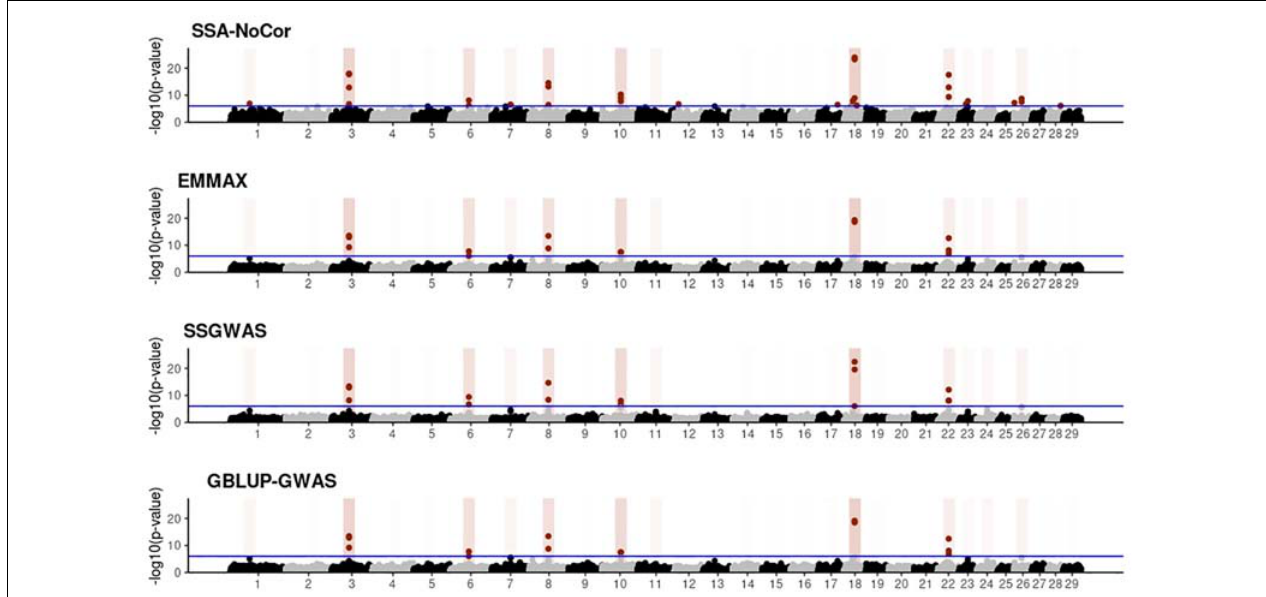
FIGURE 9 | Manhattan plots for the large population of beef cattle using single-SNP analysis without correction for population structure (SSA-NoCor), efficient mixed-model association expedited (EMMAX), single-step GWAS (ssGWAS), and genomic best linear unbiased prediction GWAS (GBLUP-GWAS). Significant SNPs are indicated in red, whereas vertical bars indicate the position of the simulated quantitative trait nucleotide (QTN). The darker the vertical bar, the stronger QTN effect. The blue horizontal line corresponds to the rejection threshold based on a significance level of 0.05 with a Bonferroni correction for multiple testing.